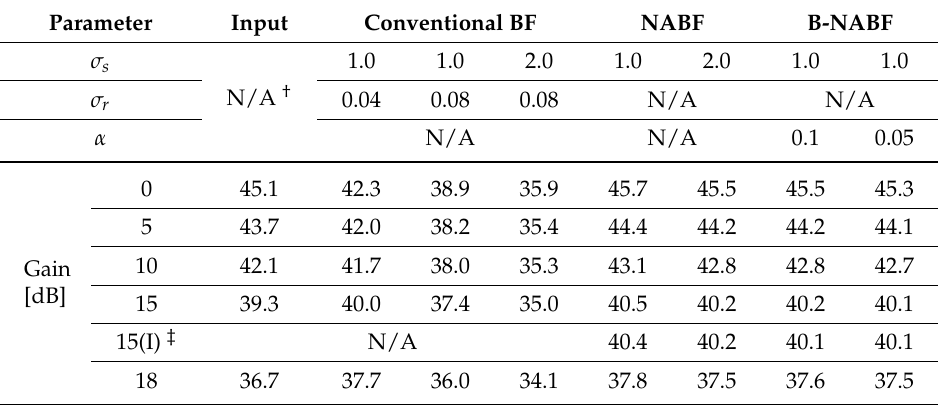
Table 1. Average peak signal-to-noise ratio (PSNR) under Various Noise Conditions.